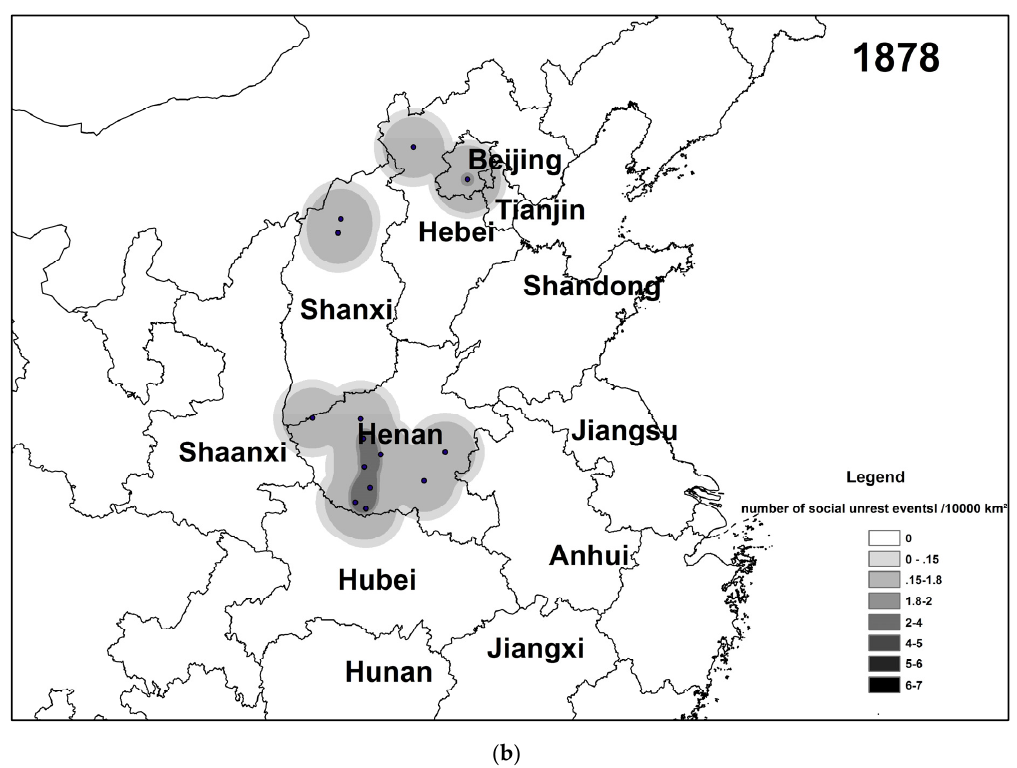
Figure 8. ( a ) Social unrest events density in 1877. ( b ) Social unrest events density in 1878.